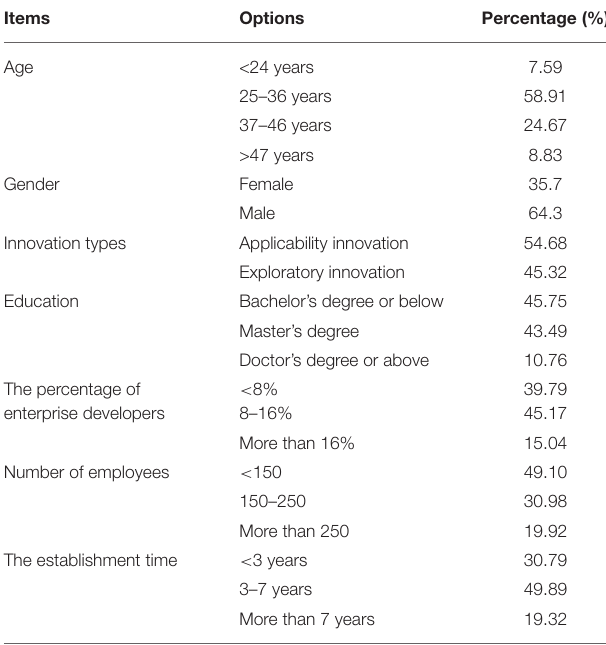
TABLE 2 | Statistical results of specific information of